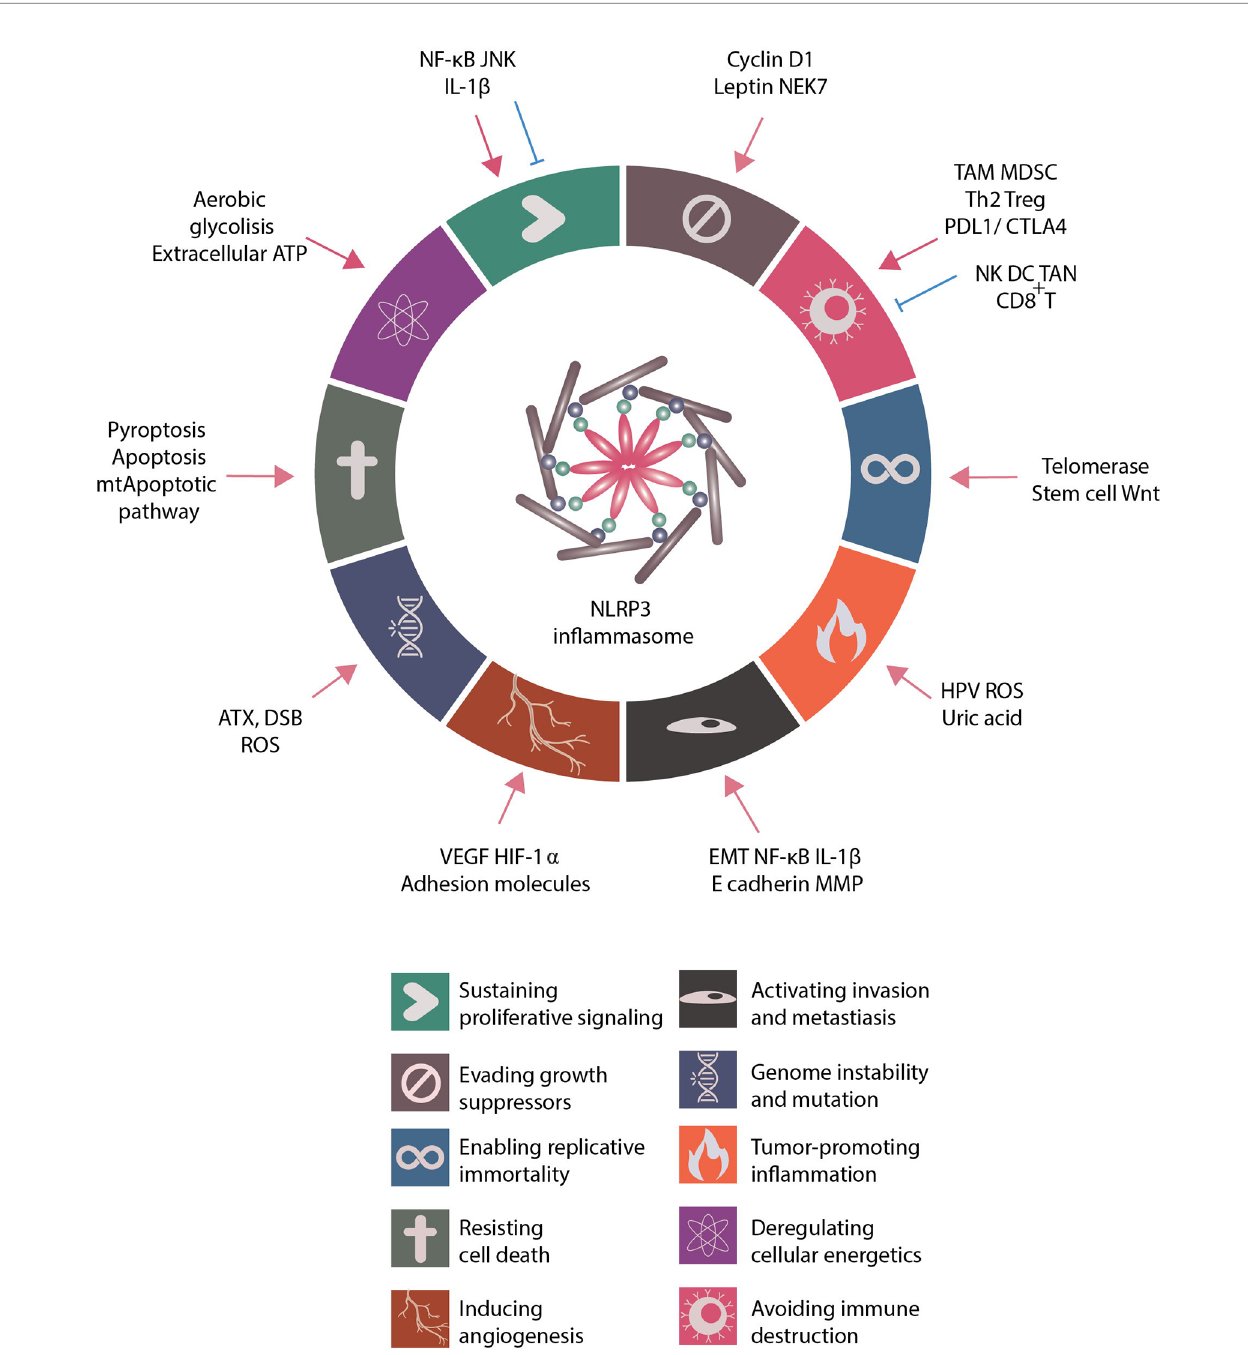
FIGURE 2 | Role of NLRP3 in fl ammasome in regulating cancer hallmarks. Proposed by Dr. Douglas Hanahan and Dr. Robert A. Weinberg, the cancer hallmarks are universal abilities that cancer cells acquire for survival. These hallmarks include sustaining proliferative signaling, evading growth suppressors, resisting cell death, enabling replicative immortality, inducing angiogenesis, activating invasion and metastasis, deregulating cellular energetics, avoiding immune destruction, tumor- promoting in fl ammation and genome instability and mutation. The related literature was reviewed and the role of NLRP3 in fl ammasome in regulating cancer hallmarks summarized. Many NLRP3 in fl ammasome-related inducers and NLRP3 in fl ammasome-associated regulations modulate the activities of cancer